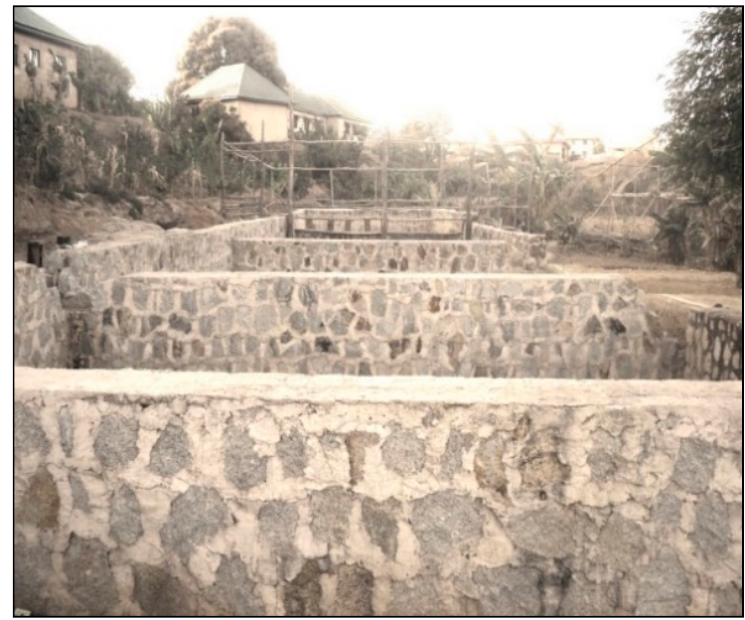
Figure 4. Concrete stone ponds.